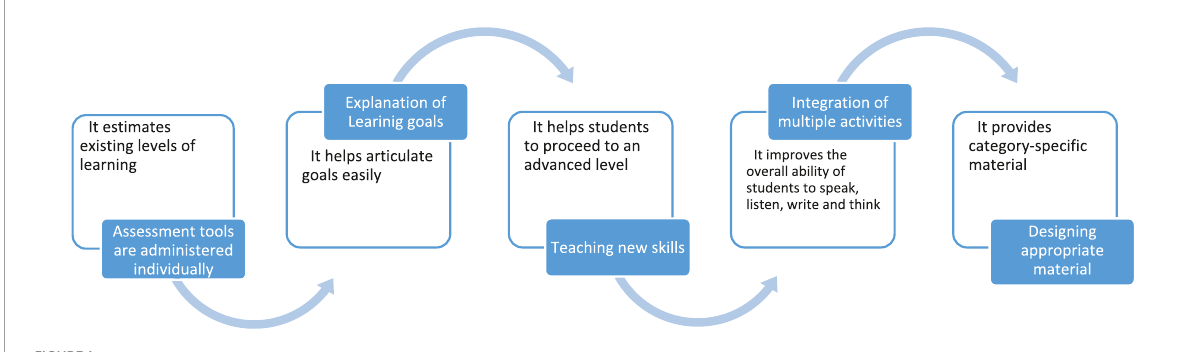
FIGURE1 Steps for TaRL (suggested by Pratham, created by the authors).